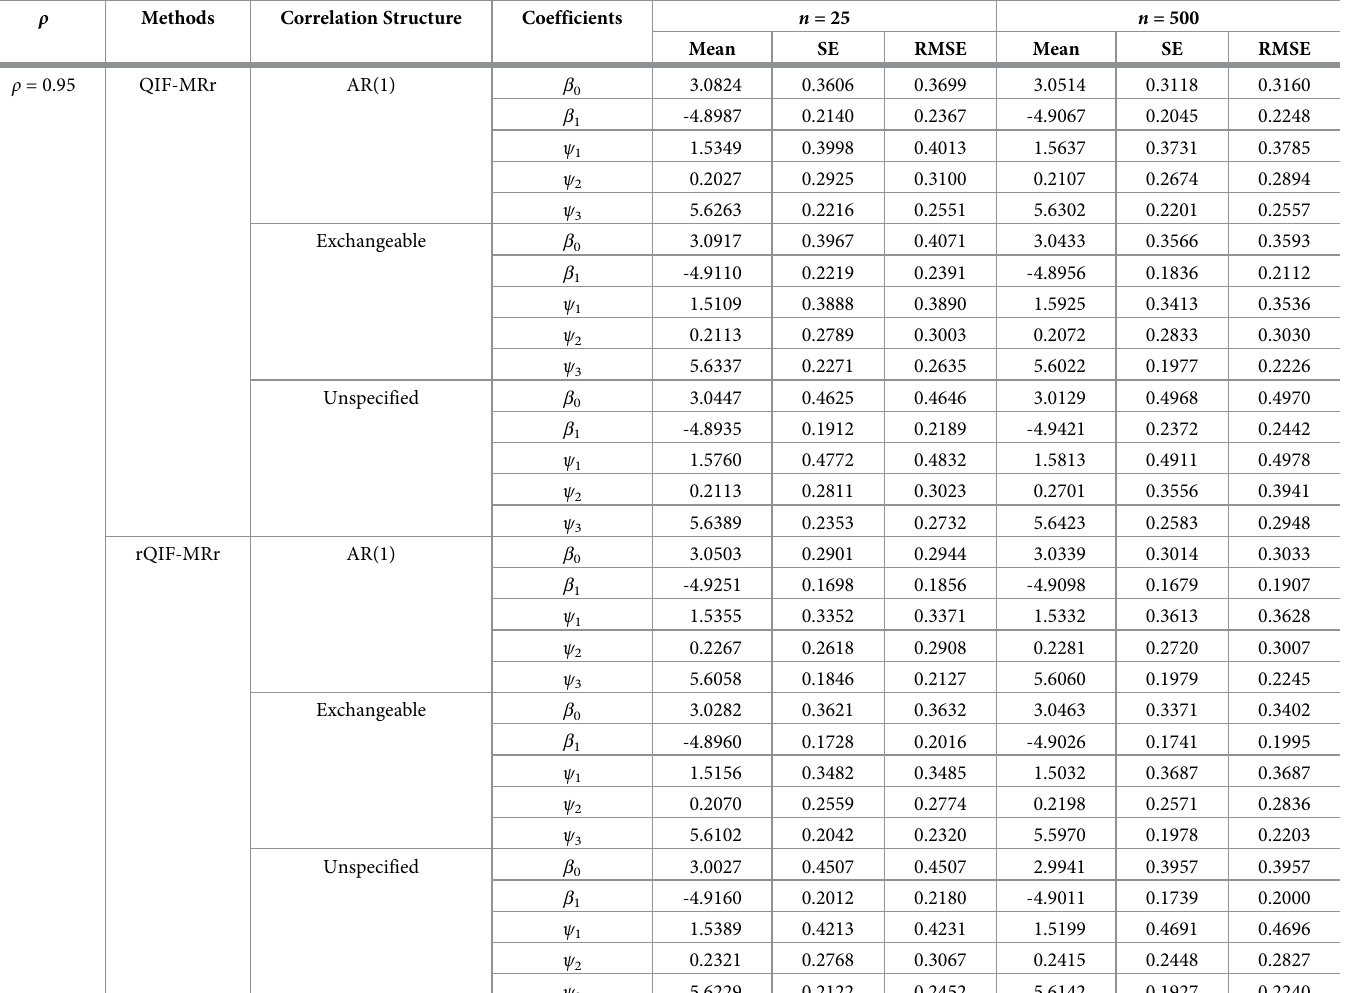
Table 4. Parameter estimation of the misspecification working correlation structures for the QIF-MRr and rQIF-MRr at high correlation value, ρ = 0.95. ρ Methods ρ =